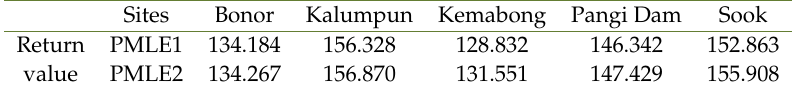
Table 3. Return Value